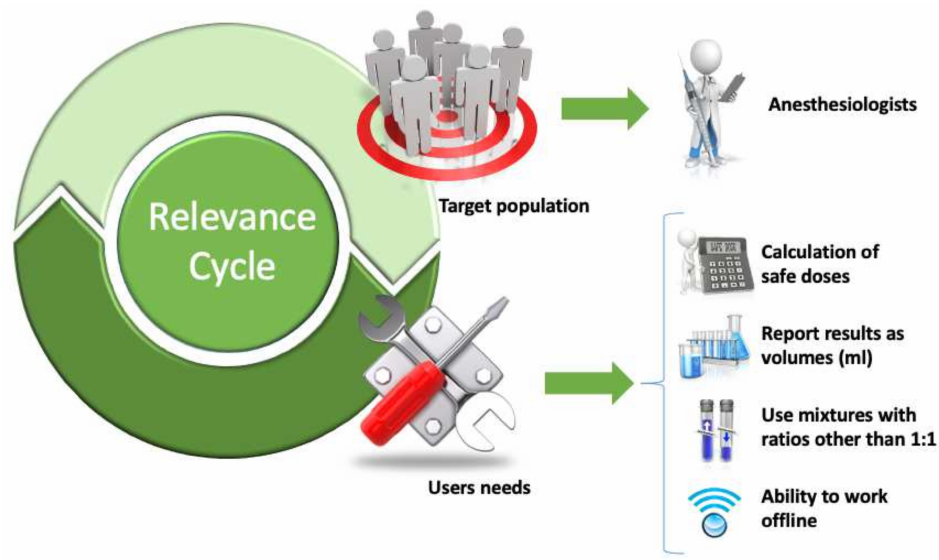
Figure 2. Results of the relevance